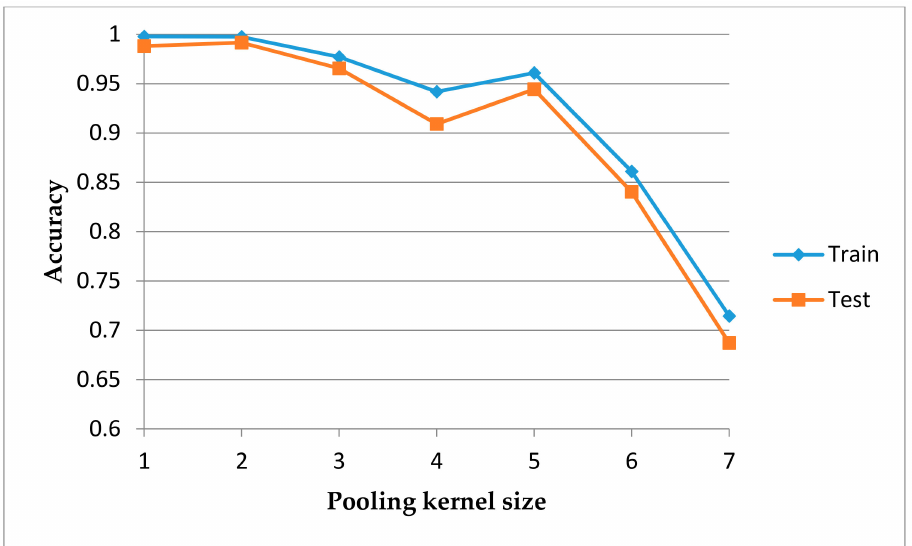
Figure 8. Effects of changing the ST-CNN model pooling kernel size.